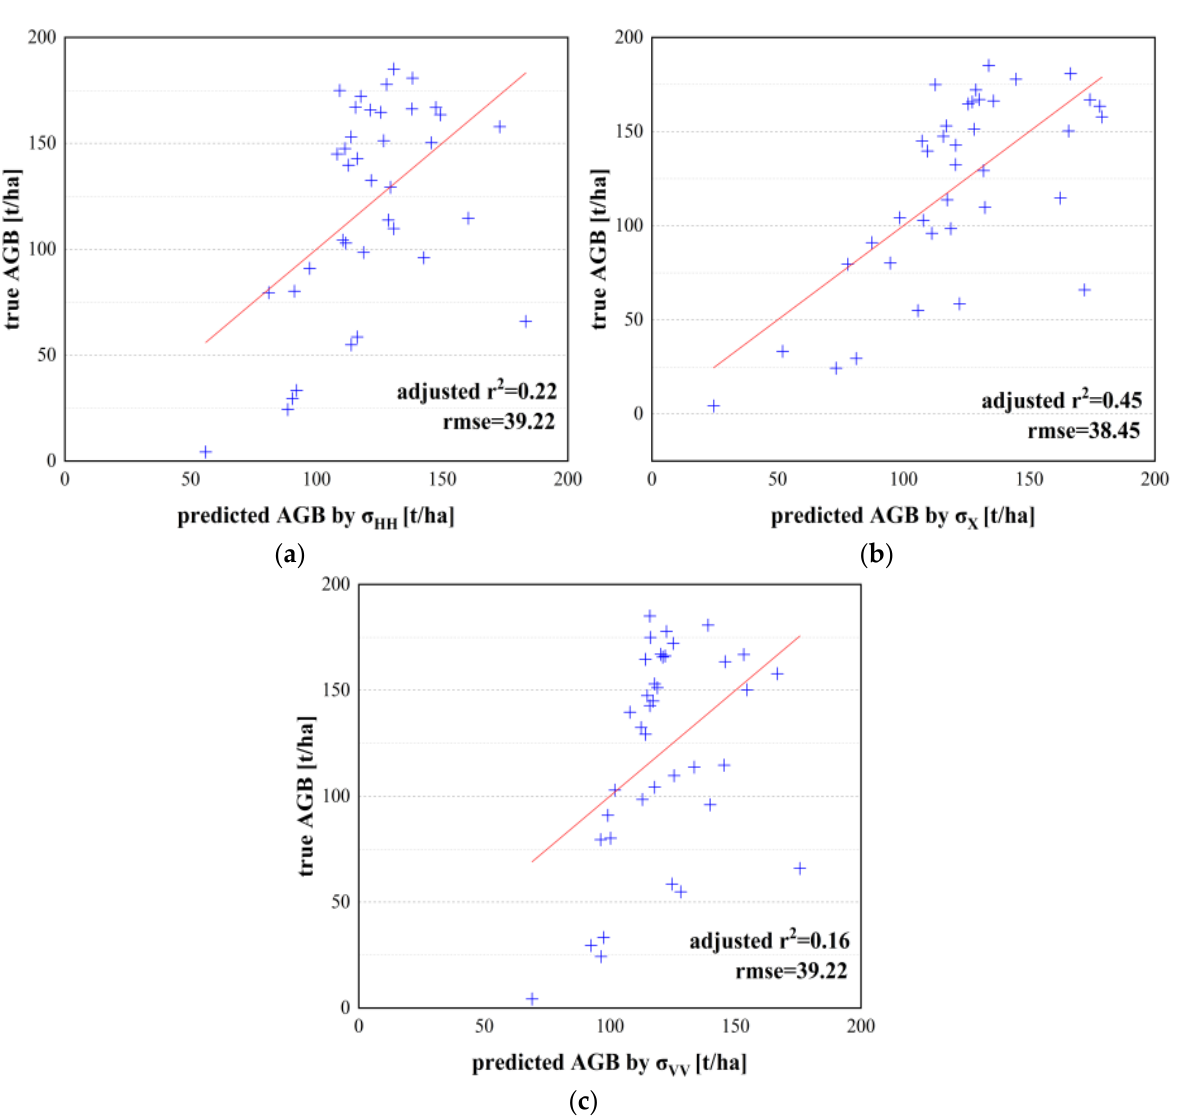
and AGB; ( c ) mod- X